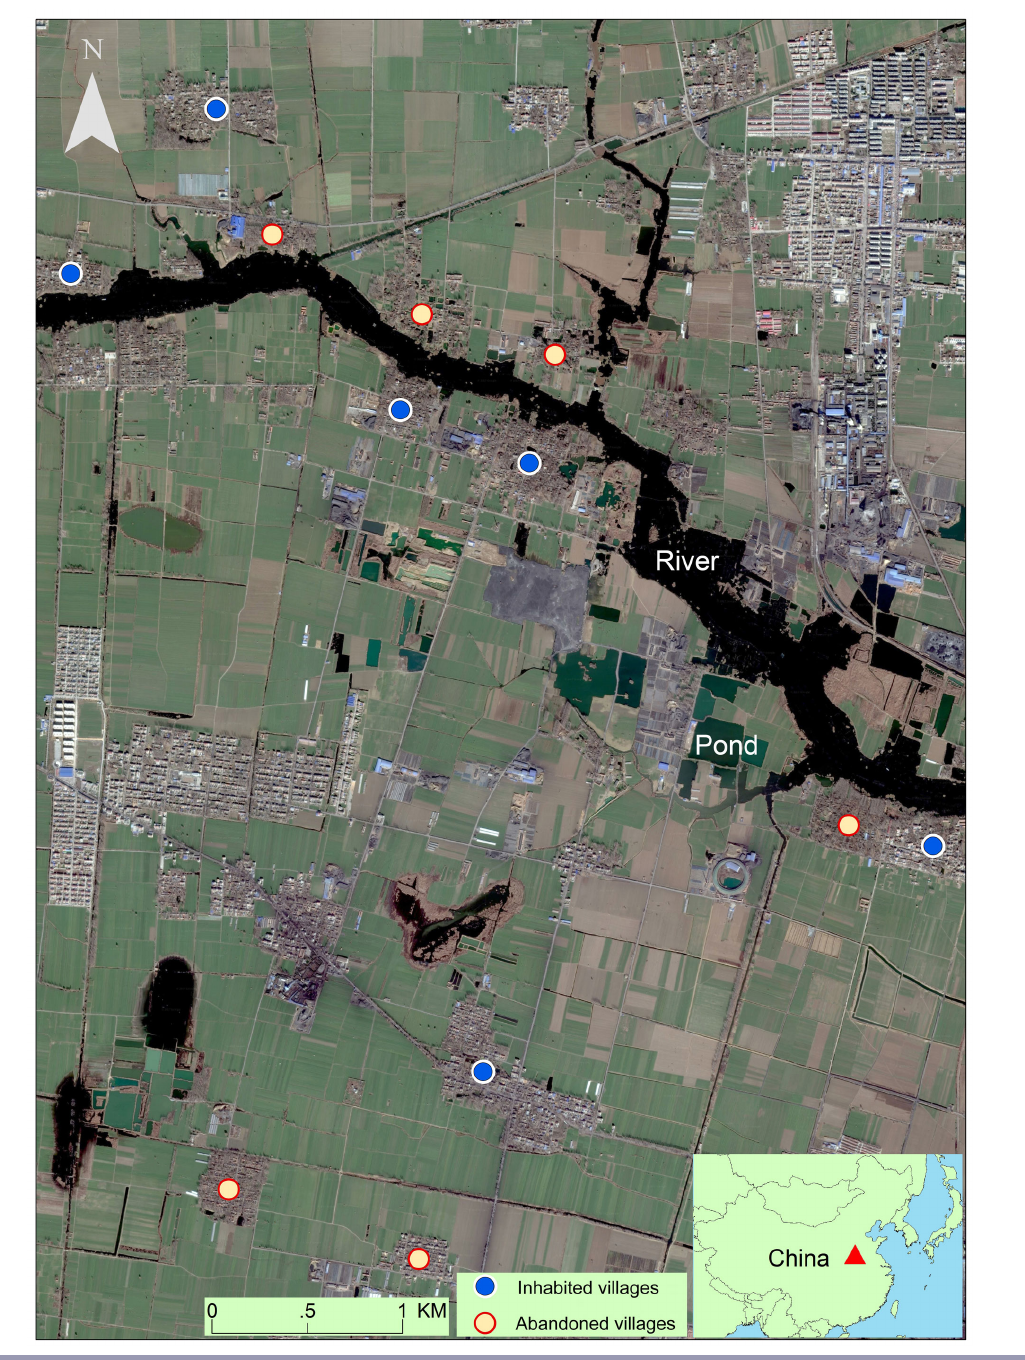
Fig. 1 . Map of surveyed villages in the Huaibei coal mining area located in the southern part of the North China